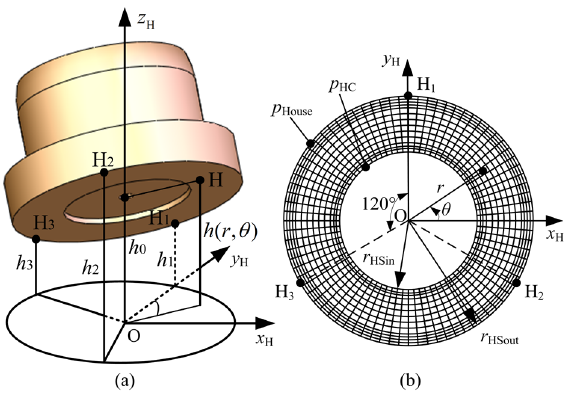
Figure 4. Control points definition of micro motions of slipper, where ( a ) is positions of control points; ( b ) is grids of oil film.